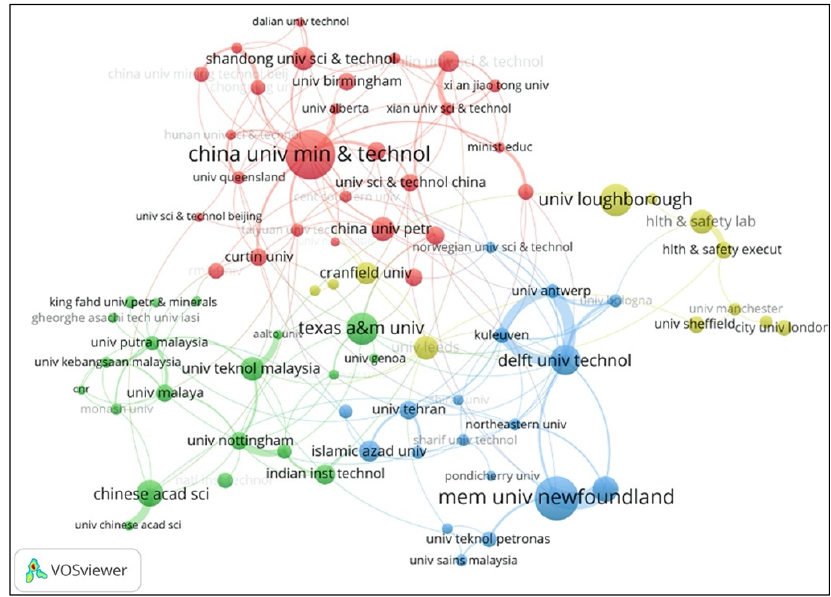
Figure 5. Institution collaboration network of PSEP publications from 1990 to 2020. Table 4. Leading institutions in PSEP based on the number of publications (minimum number of publications = 20).